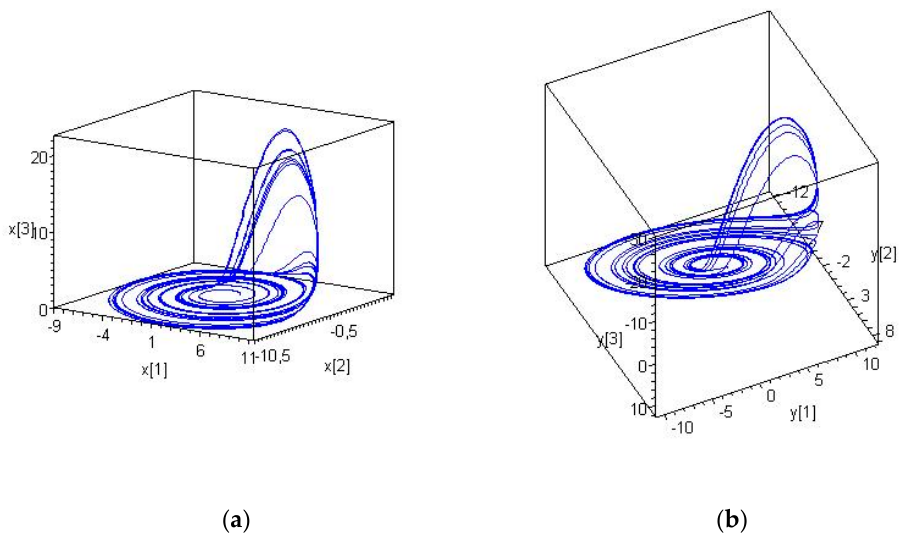
Figure 2. Rössler chaotic generator attractor for ( a ) initial and ( b ) reconstructed systems.